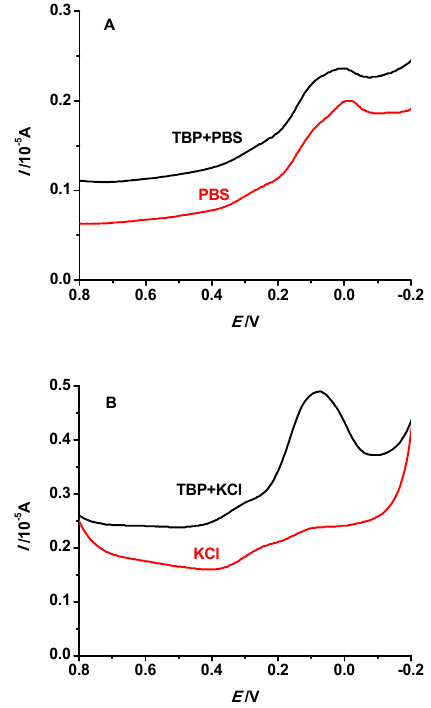
Figure 4. The differential pulse voltammetry (DPV) of the bare electrode in ( A ) phosphate-buffered saline (pH ≈ 6) with or without TBP; and ( B ) 0.3 mol·L − 1 KCl (pH ≈ 6) with or without TBP.